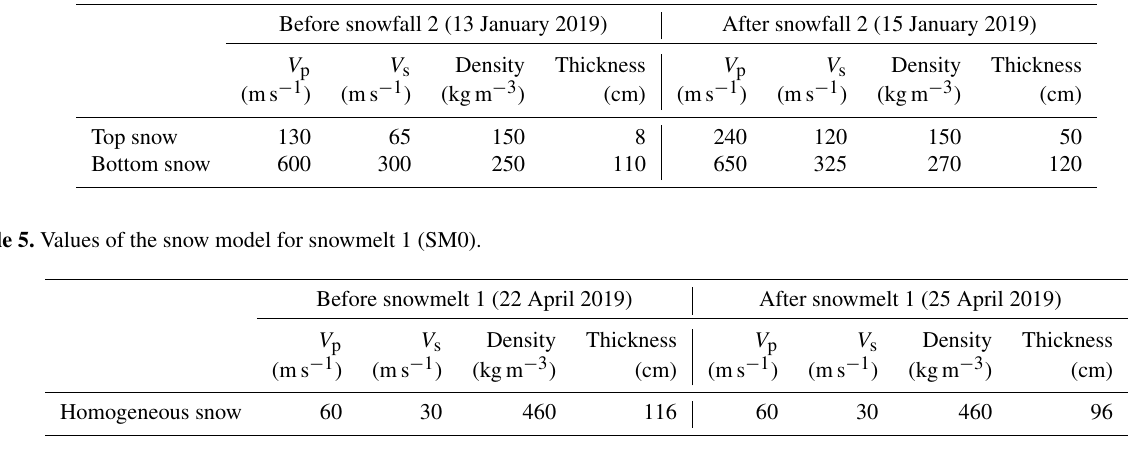
Table 4. Values of the snow model for snowfall 2 (SF2).